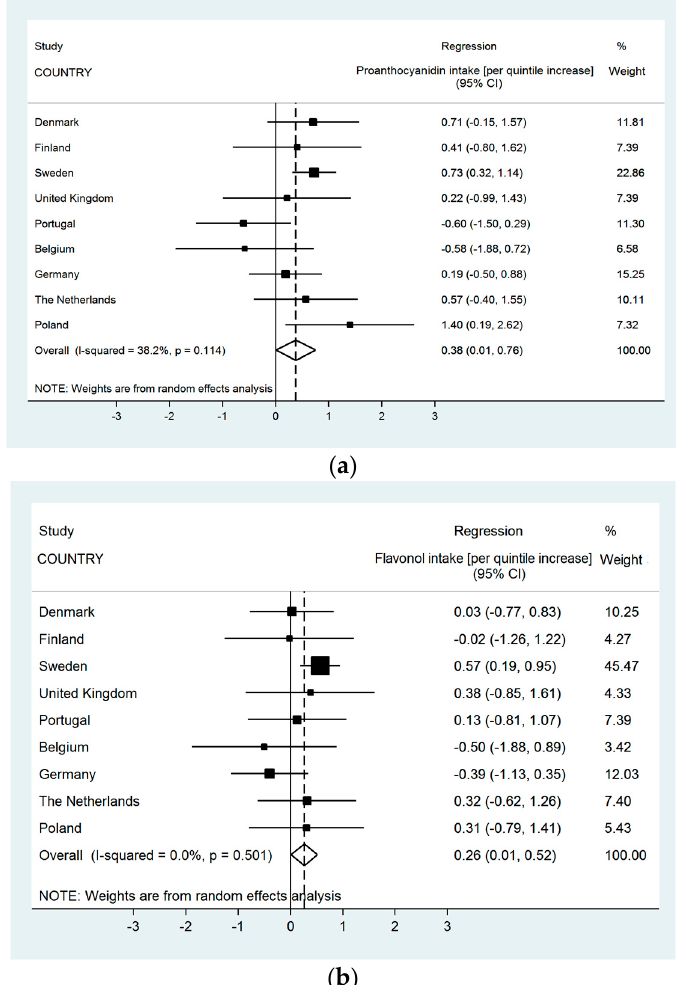
Figure 2. The association of FEV1/FVC and intakes (mg) of pro-anthocyanidins ( a ) and flavonols ( b ) (Meta-analysis of adjusted effect estimates ( β -coefficient); n = 2599).